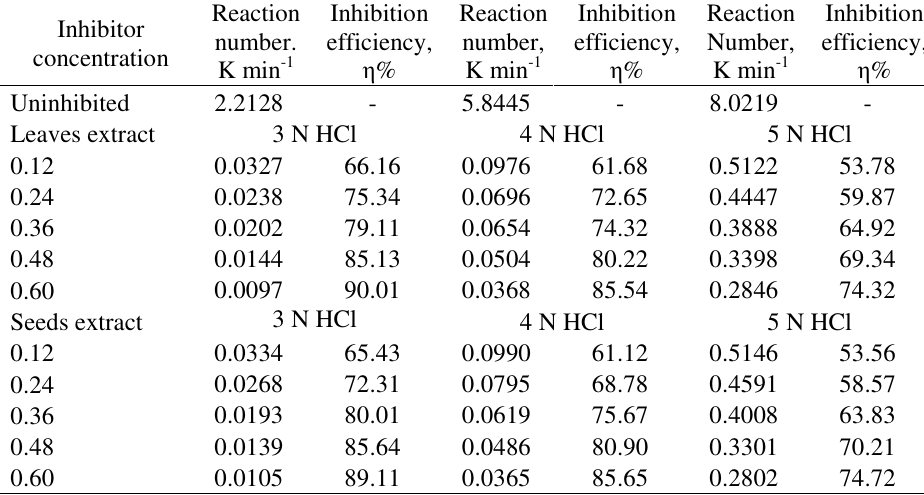
Table 4. Reaction number (RN) and inhibition efficiency ( η %) for aluminium in HCl solution with given inhibitor extract at 298 ±0.1K